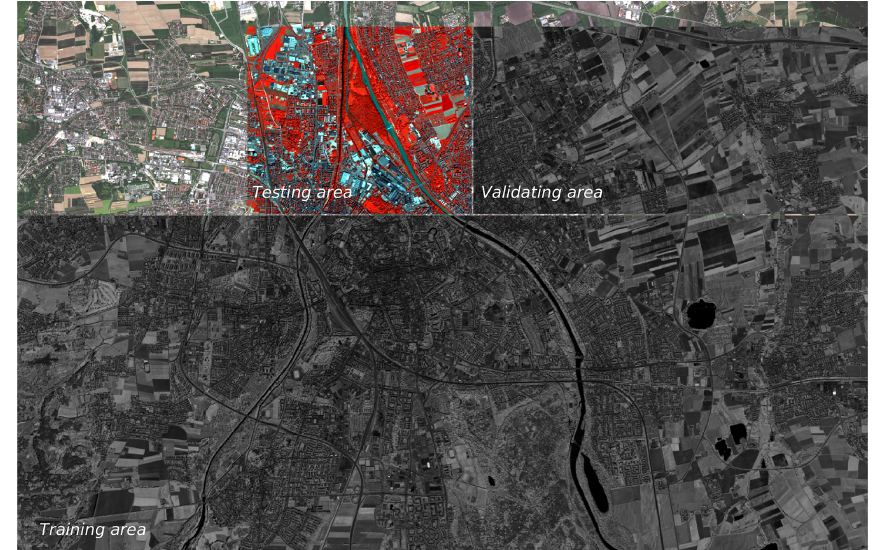
Figure 8. This figure demonstrates the data of the three regions that are used for the training, validating, and testing of the super-resolution algorithms. The visualization is based on EeteS simulated Sentinel-2 image. The background, testing area, validating area, and training area are visualized by R–G–B (663–560–492nm), IR–G–B (842–560–492nm), IR (842nm), and IR (842nm), respectively. IR is short for infrared.